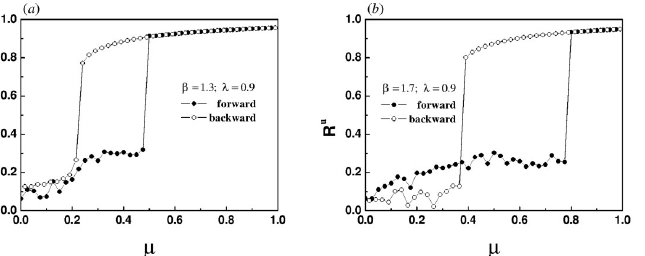
Fig 6. The evolution of order parameter of the upper layer with the increase of intra-layer coupling strength when the inter-layer coupling strength λ is set to 0.9. Both of them correspond to the super-linear correlations, (a) β = 1.3, (b) β = 1.7. Every data point in the two panels is the average of 2000 time steps after discarding the initial 2000 time steps.